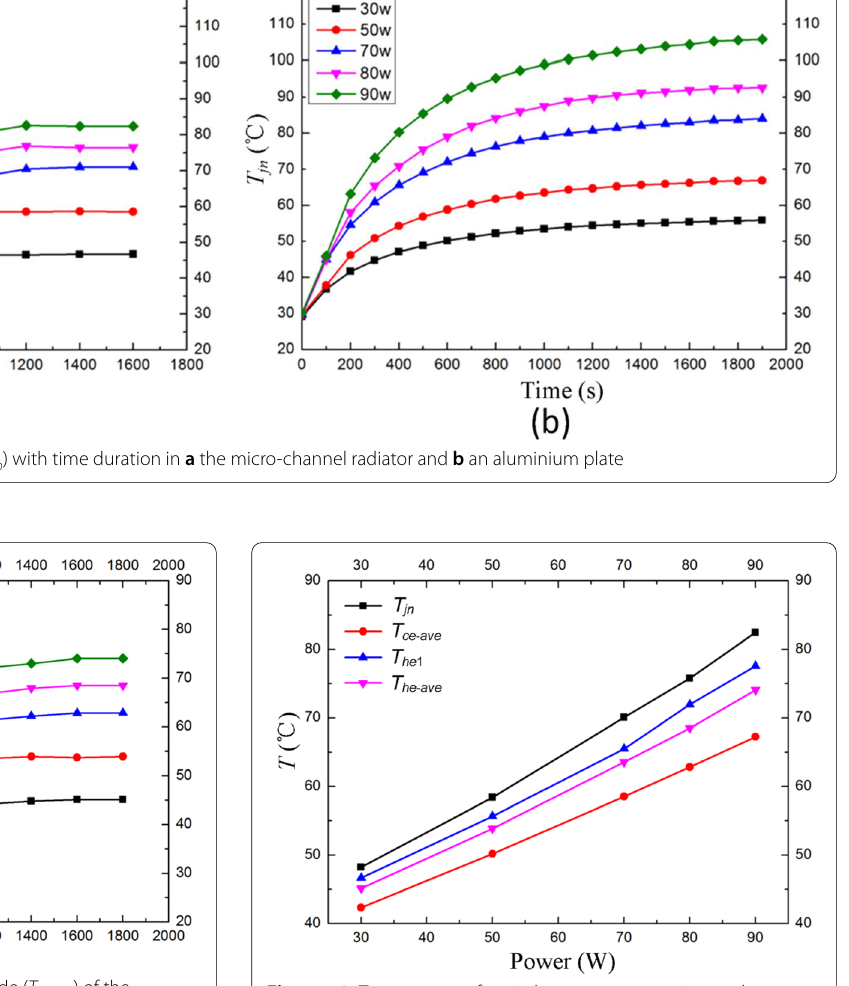
Figure 10 Temperature of typical measurement points under different input